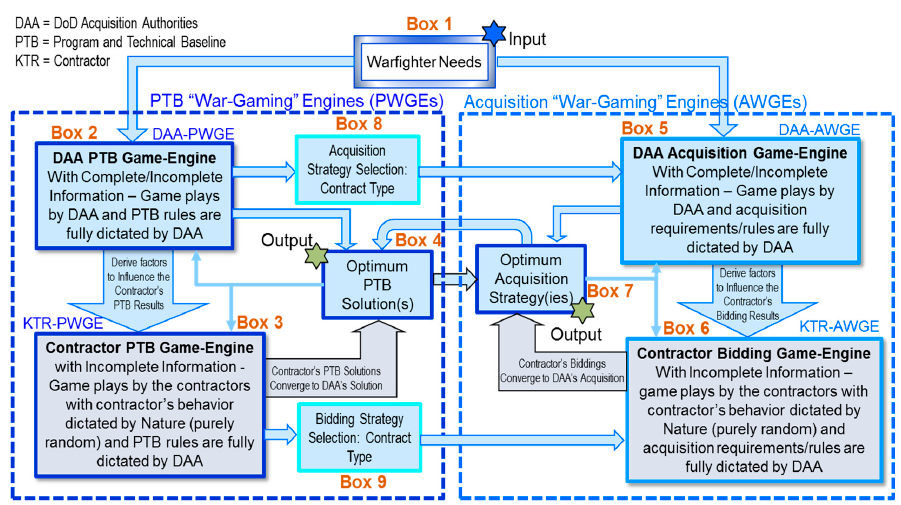
Figure 3. Unified Game-based Acquisition Framework (UGAF): A Unified Approach for Exercising AGMF [6].